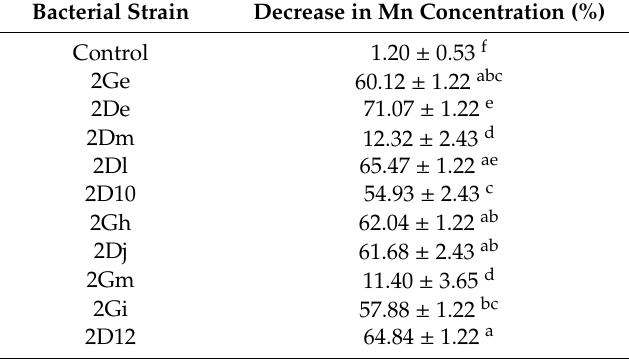
Table 2. Decrease in Mn concentration in eleven samples containing 2% ( w / v ) of the soil from metallurgical waste heap and a single, isolated strain. Error bars are ± standard deviation ( n = 3). Values within a column followed by the same letter are not significantly di ff erent at p < 0.05